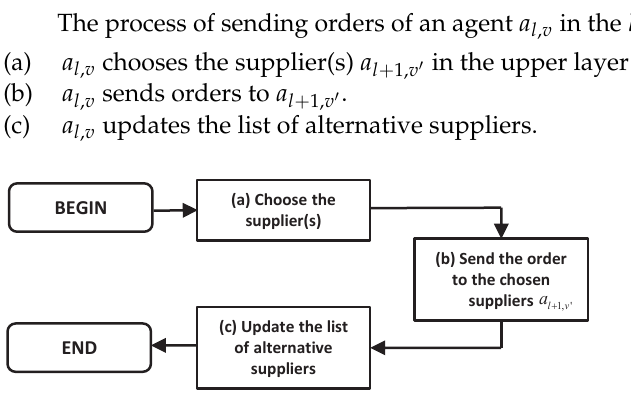
Figure 4. The process of sending